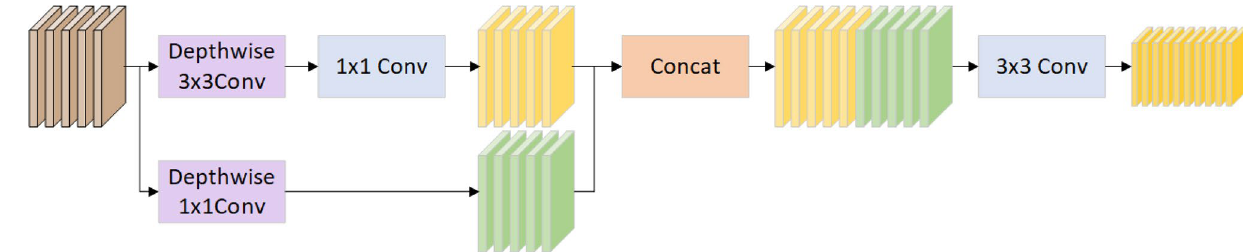
Fig. 3 The structure of Downlayer